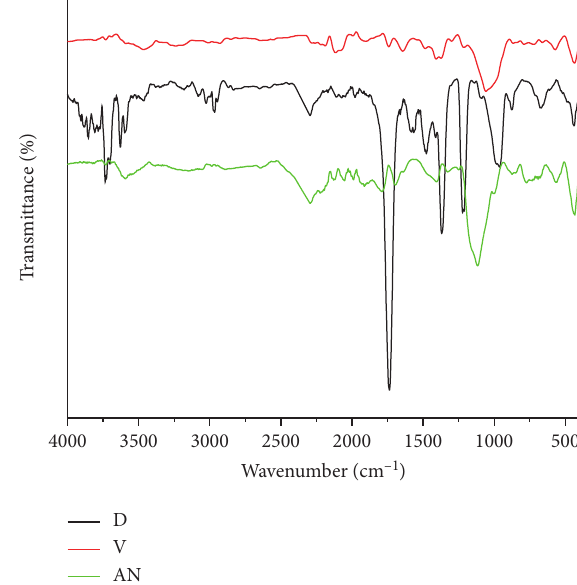
Figure 10: FT-IR image of 5M and 1:1 of SH :SS.